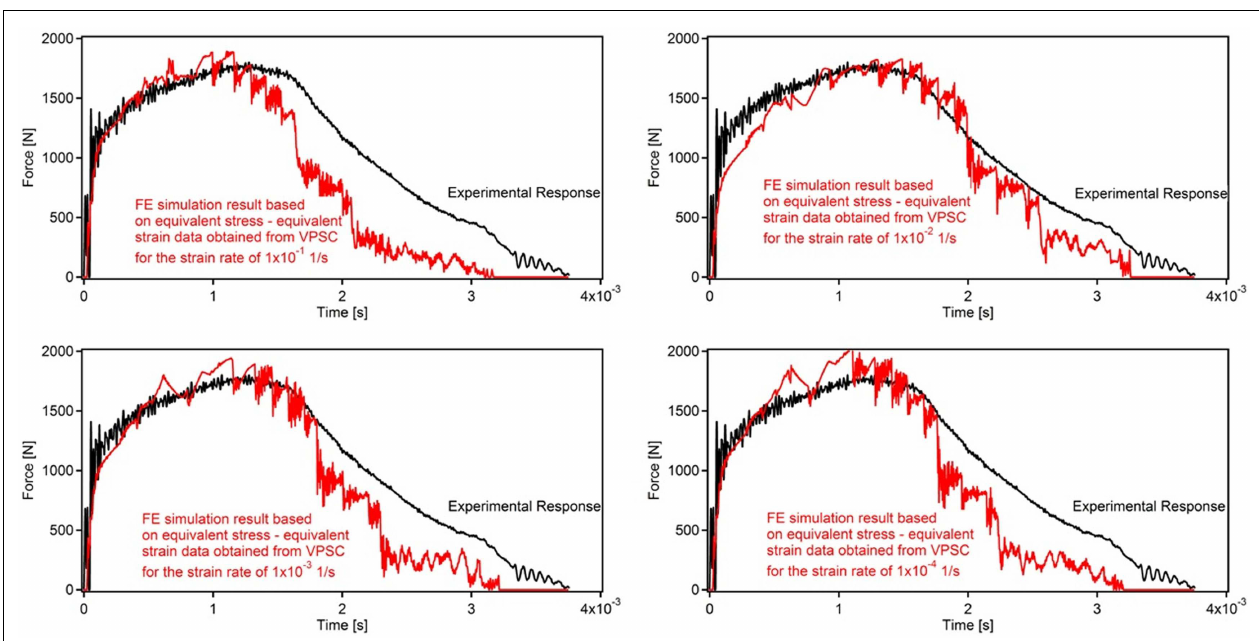
FIGURE 9 | Comparison of the experimental impact response and results of the FE simulations incorporating equivalent stress–strain responses predicted by crystal plasticity for all strain rates considered